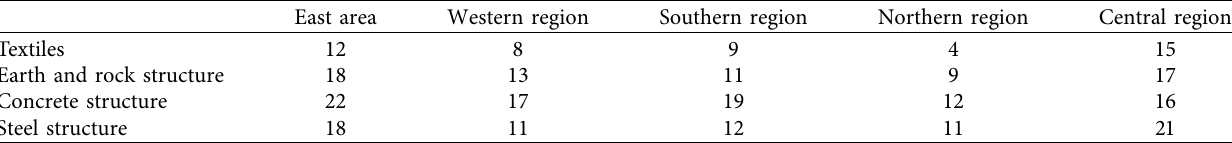
Table 1: Distribution of health monitoring